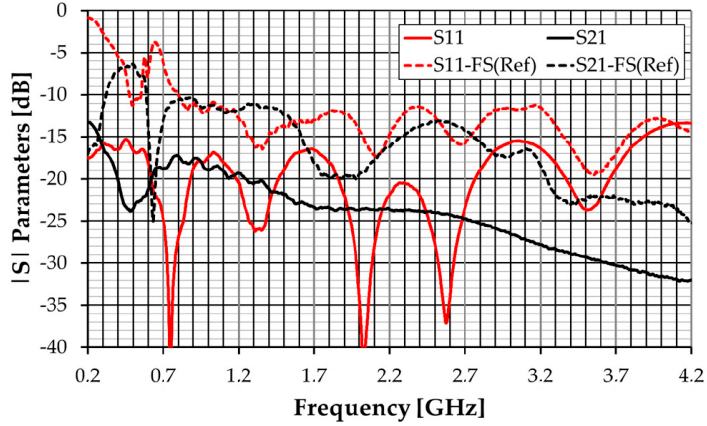
Figure 18. |S|-parameter experimental results of the modified octagonal monopole with absorber and metal shield.